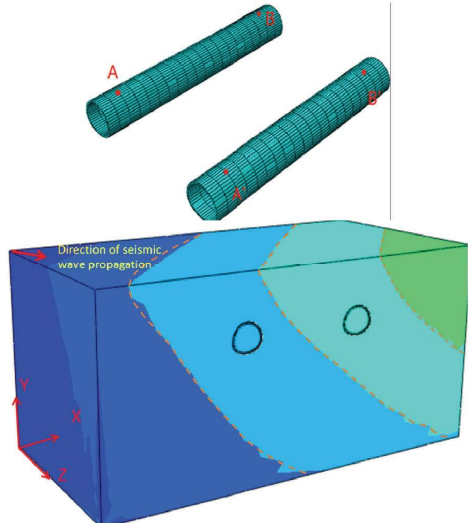
6: 3D fnite element model of the double-hole